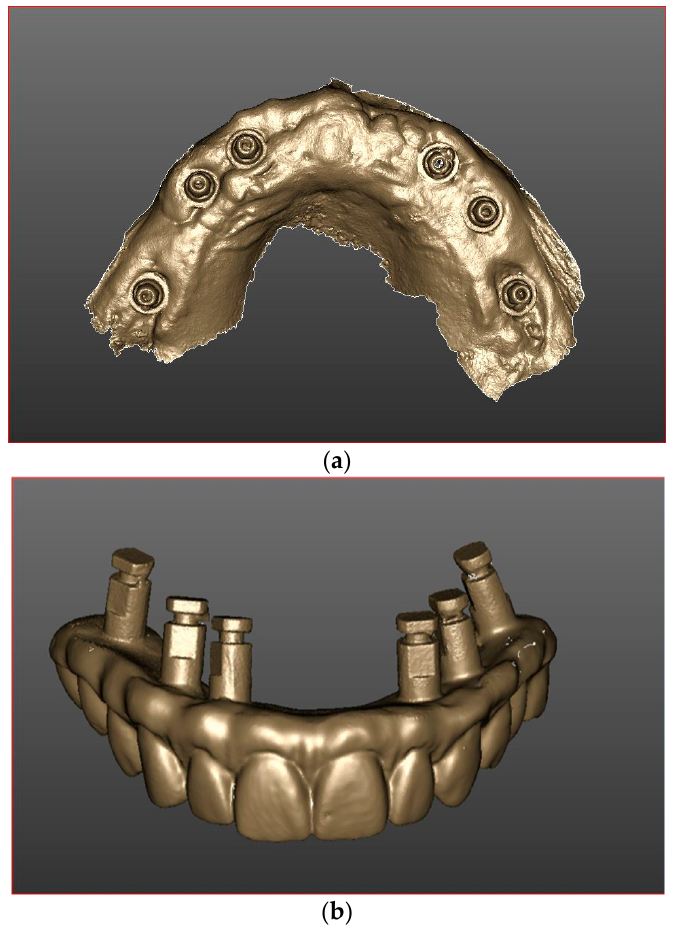
Figure 2. ( a ) Intraoral scanning of soft tissues after a 4-month healing time. ( b ). Scan of the temporary prosthesis with analogs in position.